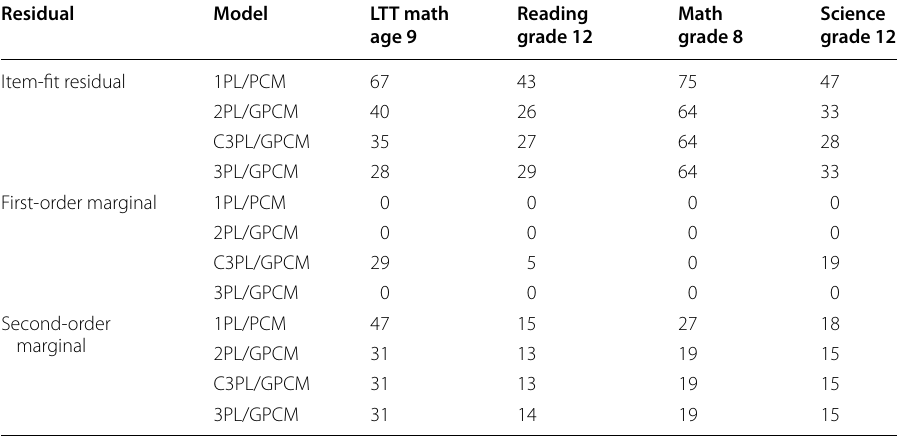
Table 6 Percent significant residuals under different unidimensional models